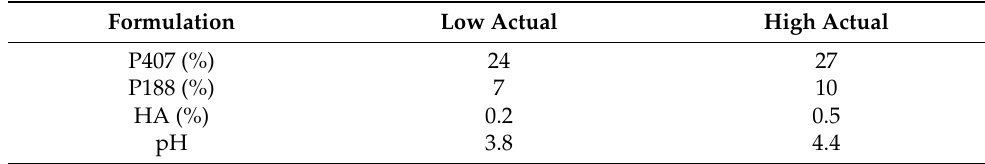
Table 1. The actual value of design variables.